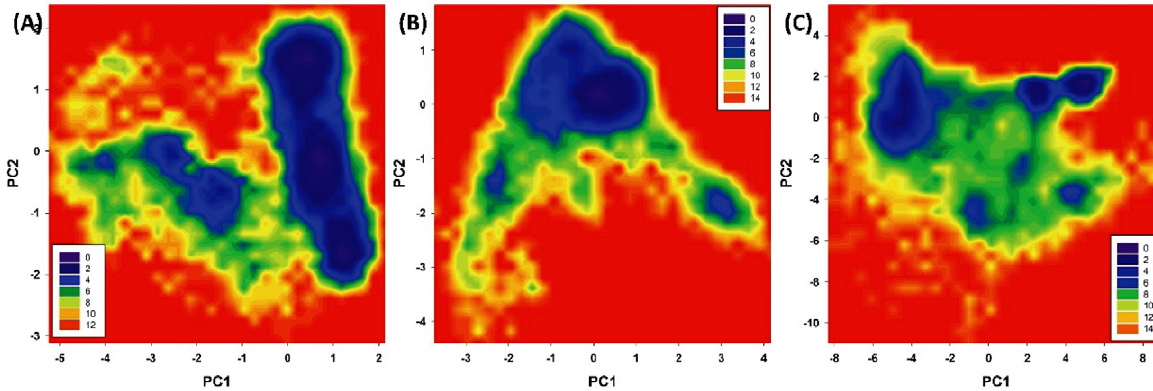
to HIV-1 protease alone were observed, indicating the structural transition in the presence of